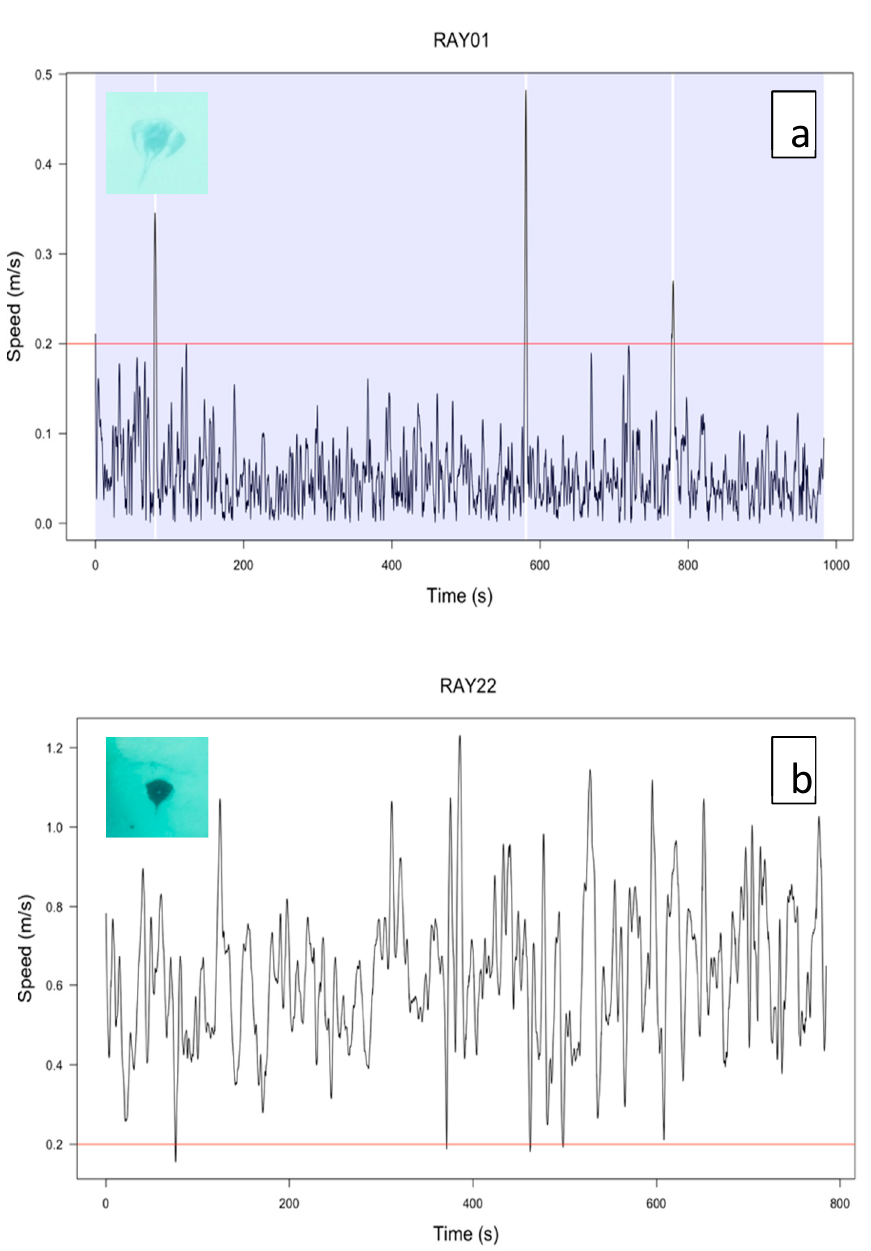
Figure 3. Speed profiles of RAY01 ( a ) and RAY22 ( b ) tracks. The red line indicates the resting threshold set at 0.2 m/s. The blue shading indicates a period of more than 5 s below the threshold. RAY01 displayed resting behavior in the drone footage, while RAY22 was swimming for the entire duration.